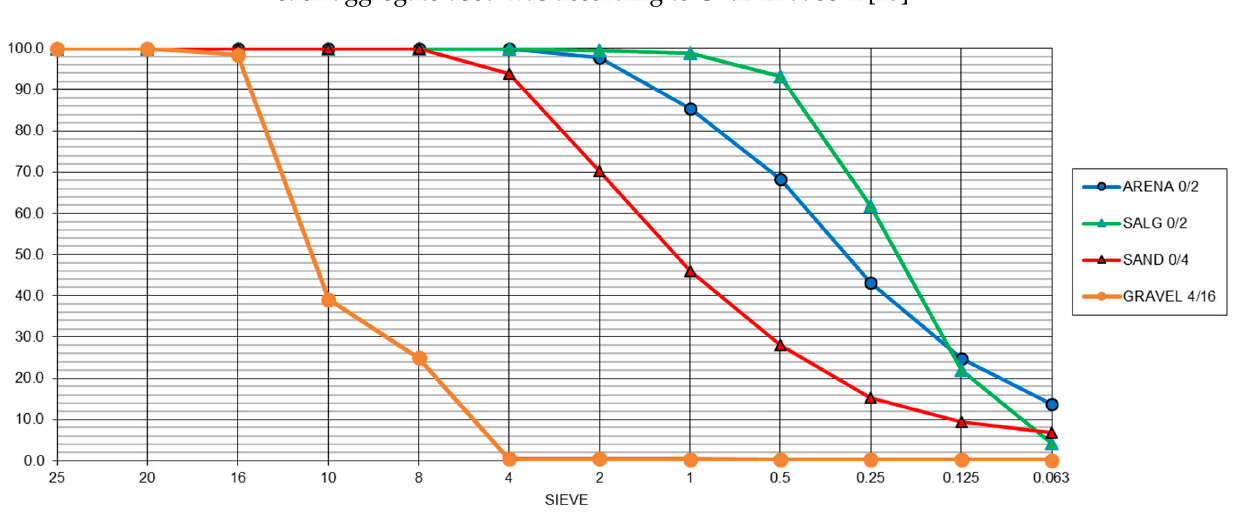
Figure 5. Sand and slag granulometry.